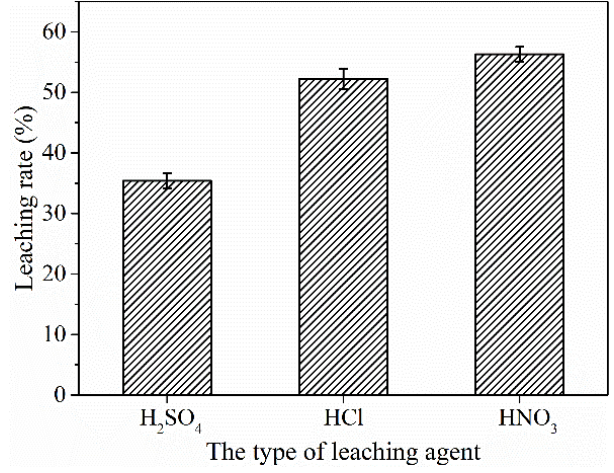
Figure 6. The effect of the type of leaching agents on REE leaching rate at 30 °C, 1.65 mol/L and S/L ratio of 1/10 for leaching 2 h.